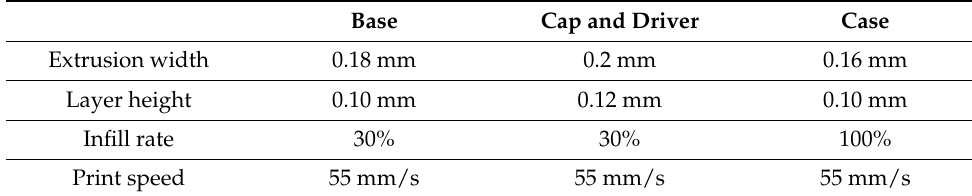
Table 1. Connector printing settings.